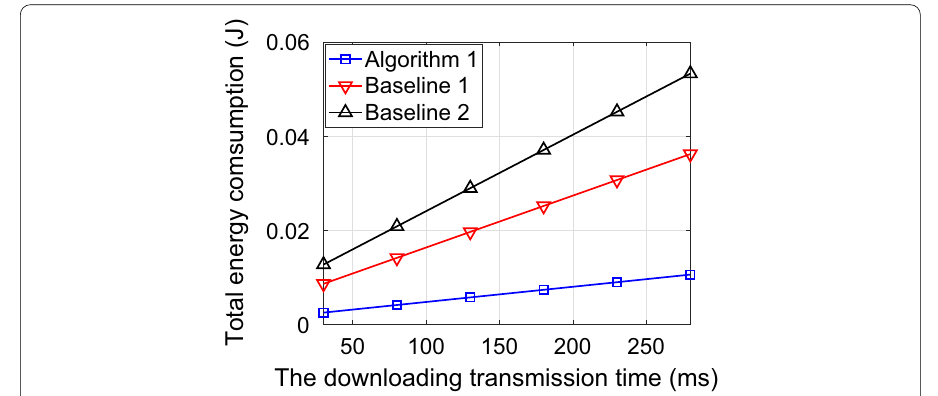
Fig. 5 The total energy consumption versus the downloading transmission time, τ